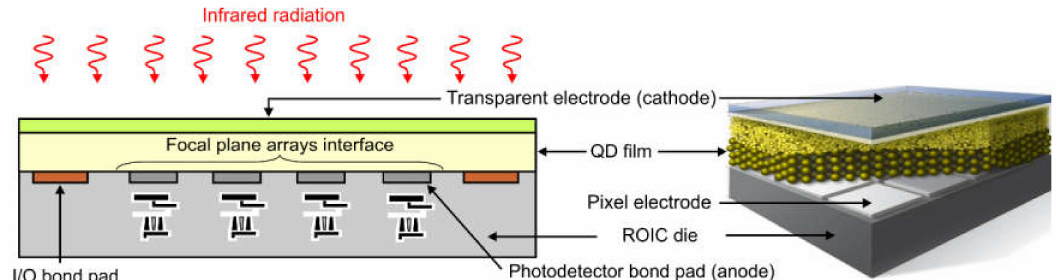
Figure 19. IR monolithic array structure based on